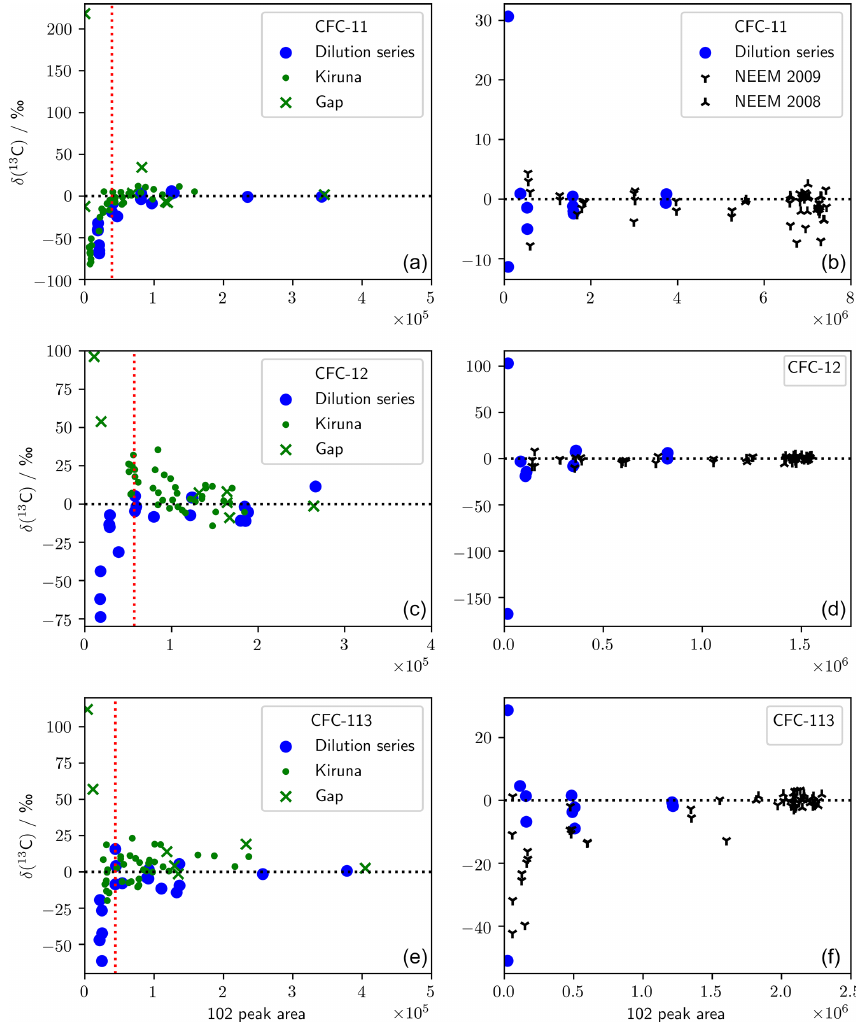
Figure A1. Dilution series for the analytical methodologies used in this work. (a, c, e) Method A, which was used to measure stratospheric samples. The dotted red line shows the lower limit of m/z 102 peak areas that were retained. (b, d, f) Method B, which was used to measure firn air. Dilution series measurements are relative to SX-0706077 (2009 air), and stratospheric and firn air measurements are relative to AAL (2005